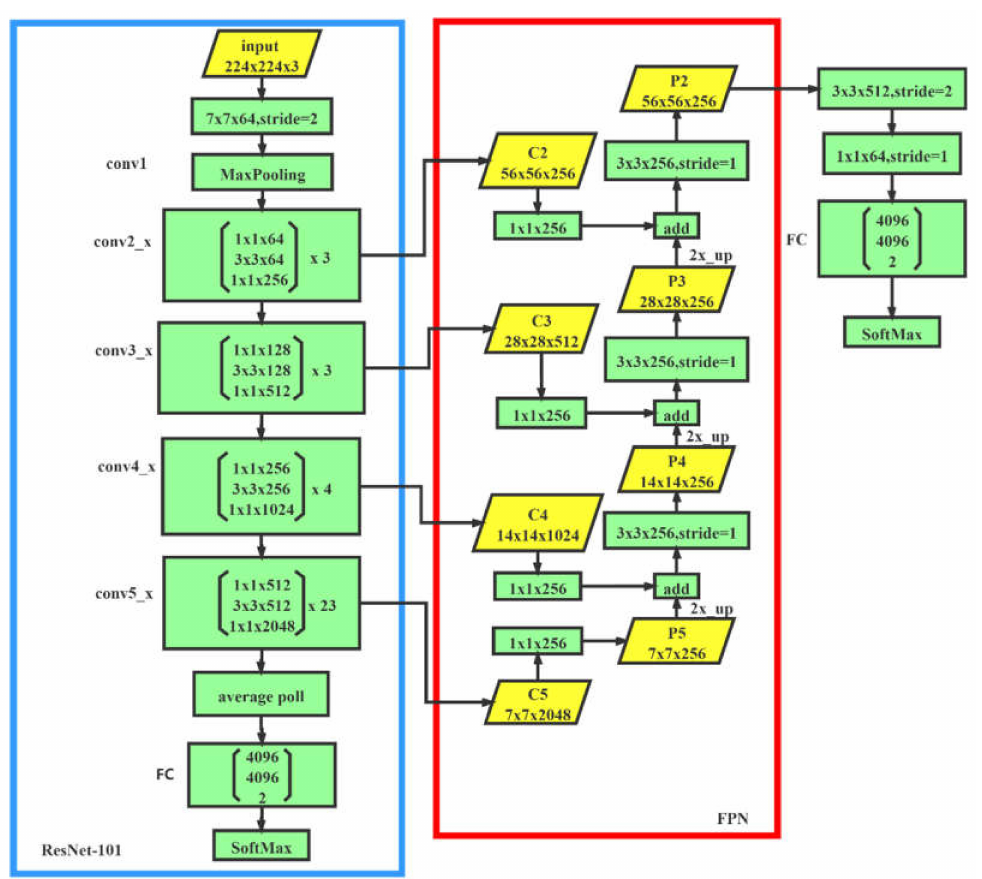
Figure 6. Final network structure of the ResNet101 + feature pyramid network